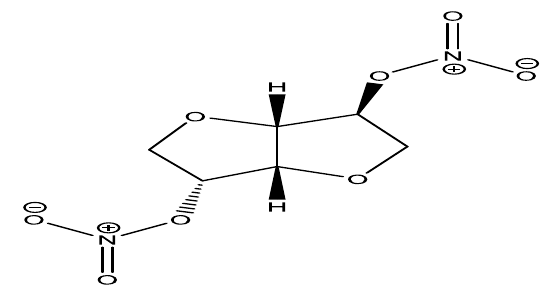
Figure 2: Chemical structure of Isosorbide dinitrate